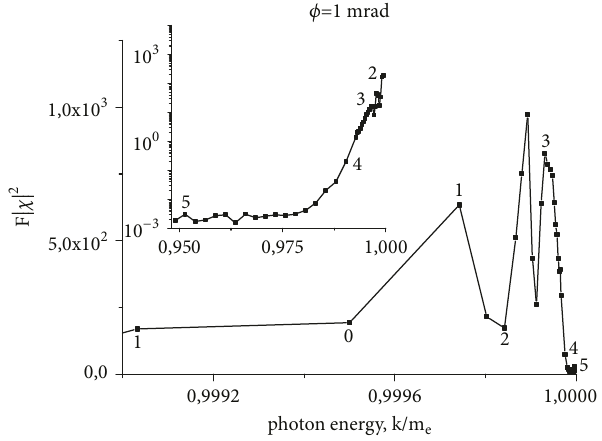
Figure 6: The integrand 𝐹|𝜒| 2 as a function of the photon energy 𝑘 for the angle 𝜙 = 1 mrad and 𝑘 ≥ 𝑘 0 = 0.999 . Inset: the same except for 𝑘 ≤ 𝑘 0 . For the labeled points the energies of massless bosons are given in the text.